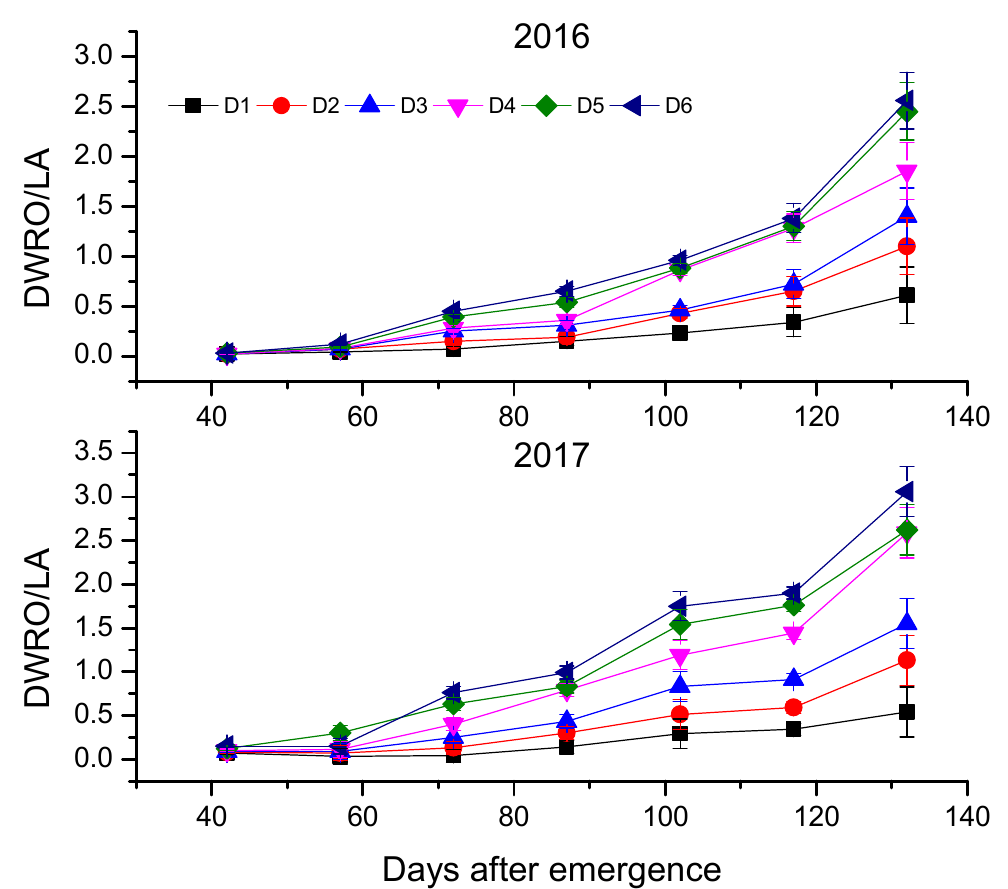
Figure 4. Ratio of dry weight of reproductive organs per leaf area (DWRO / LA) in 2016 and 2017 growing seasons.